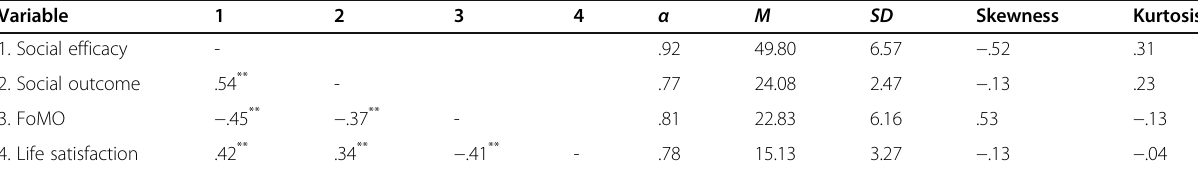
Table 2 Correlation matrix of primary study variables Variable